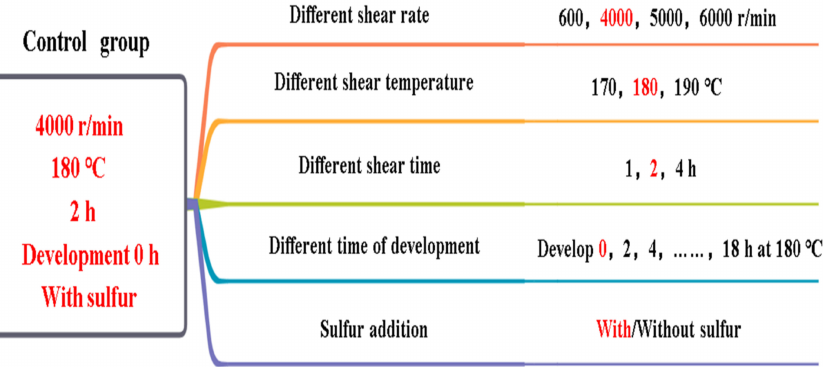
Figure 1. Different preparation methods discussed in this